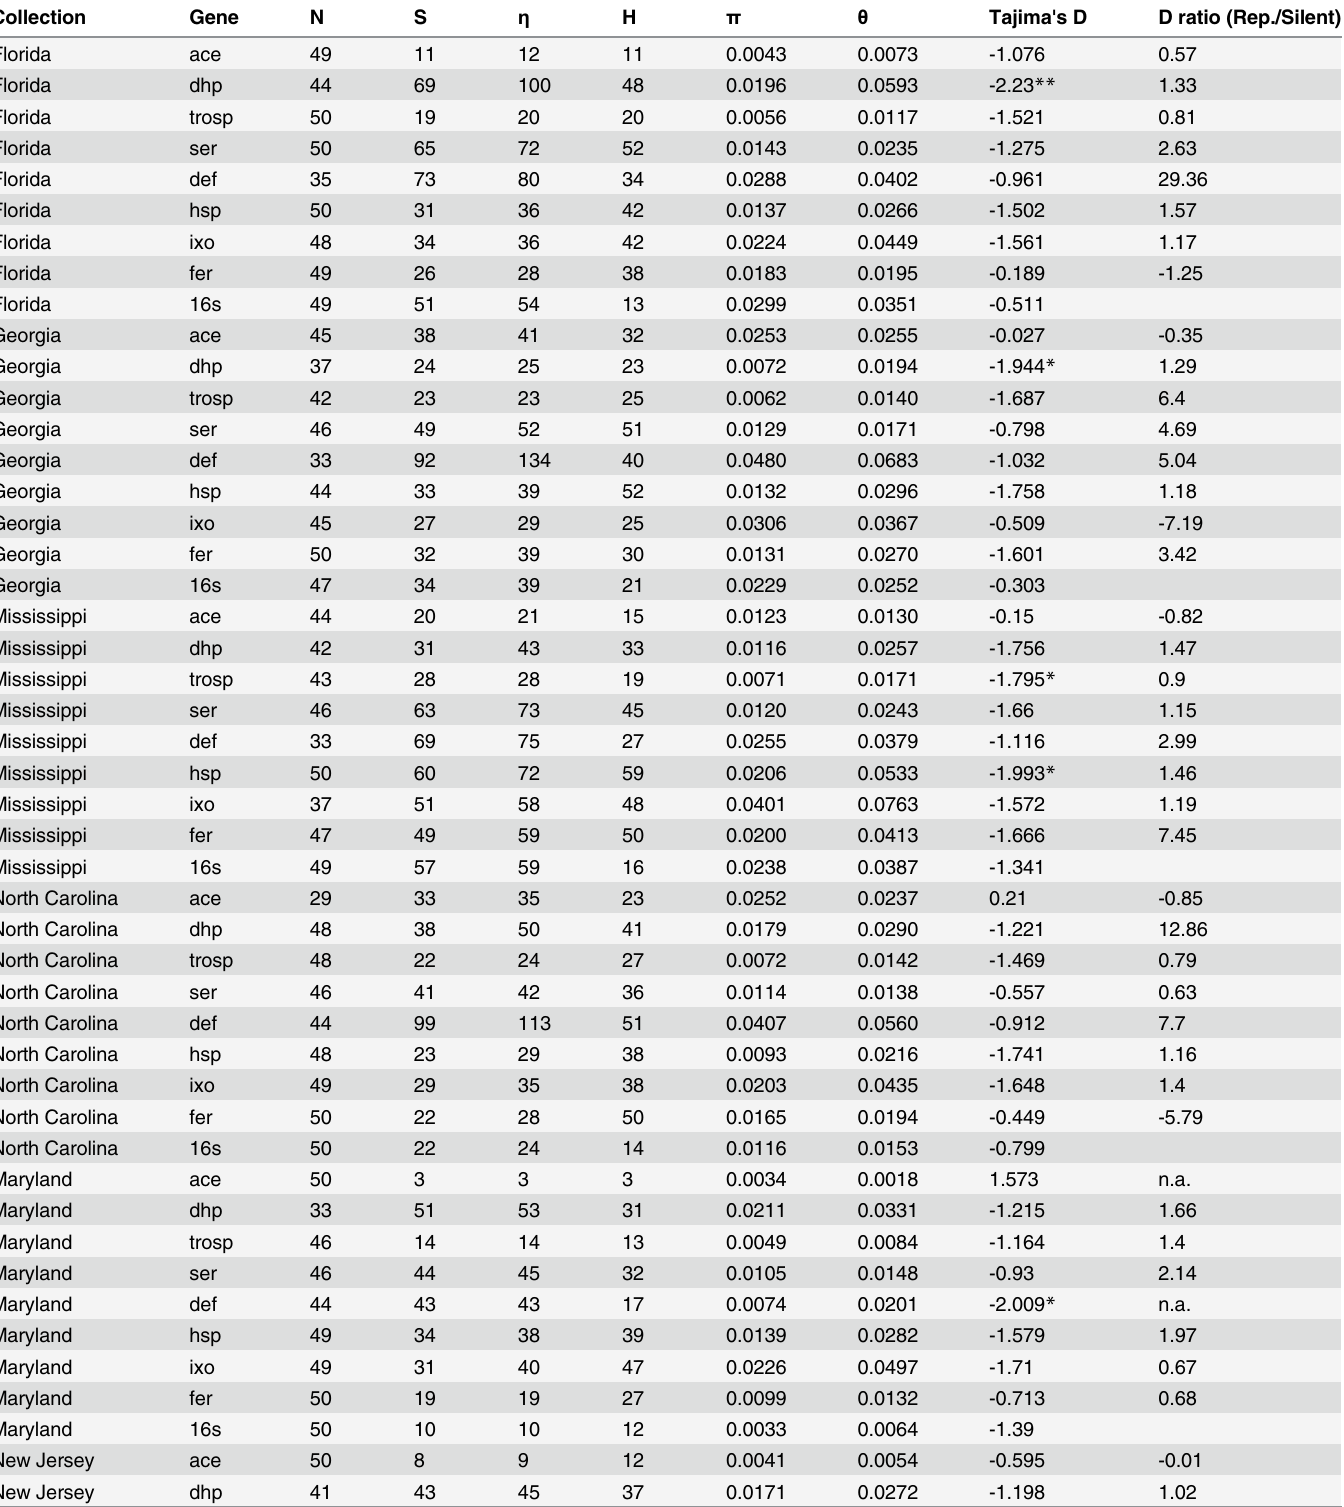
Table 2. Summary of sample sizes and variability in the nine genes in each of the seven collection